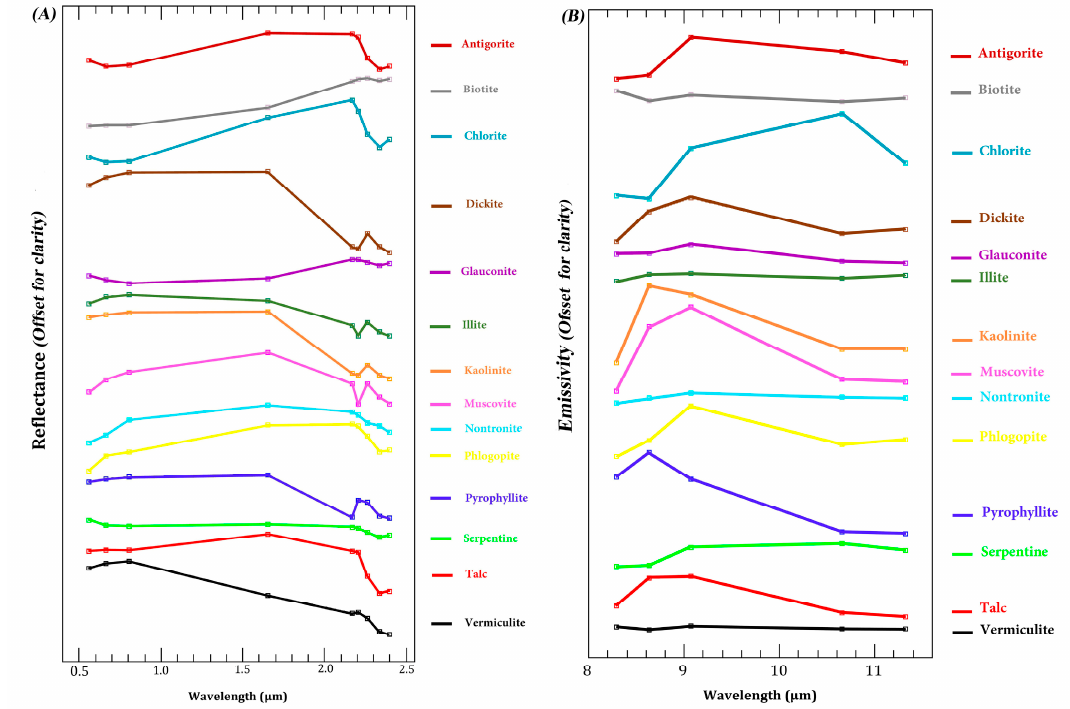
FIG 4 Figure 4. Laboratory reflectance spectra of the selected phyllosilicate minerals re-sampled to response functions of ASTER VINR+SWIR and TIR bands. ( A ) ASTER VINR+SWIR bands; ( B ) ASTER TIR bands. Cubes indicate the location of the ASTER VINR+SWIR and TIR